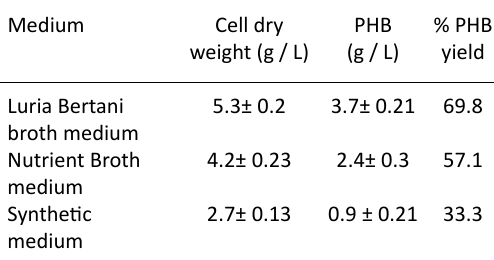
Table 3. Effect of LBM, NBM, and Synthetic medium on production of PHB by Bacillus sp.